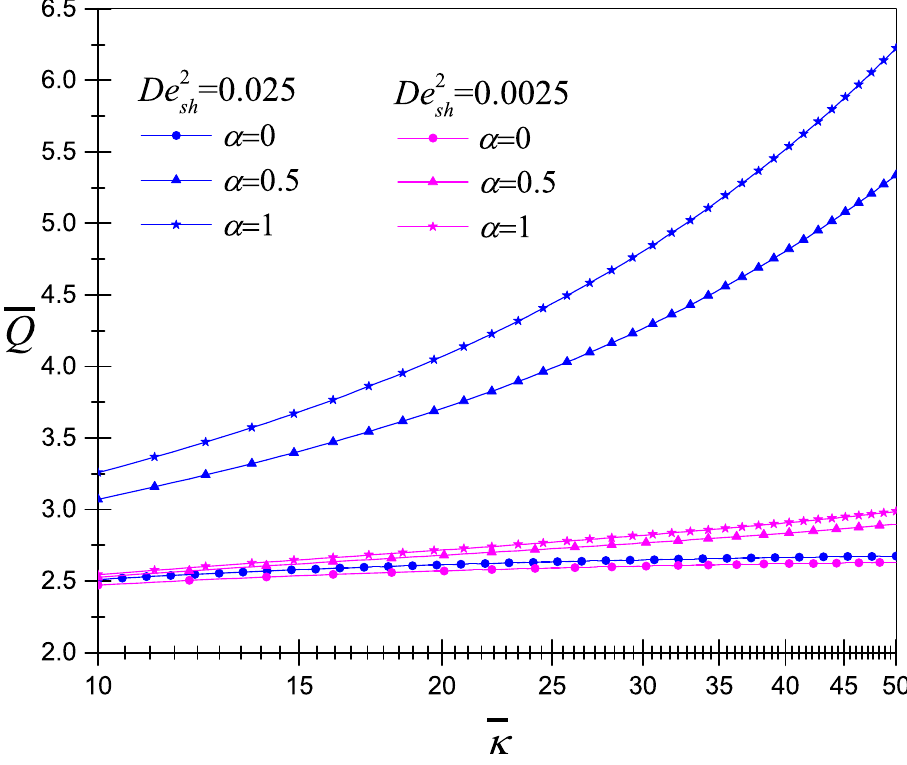
Figure 9. The volumetric flow rate as a function of the electrokinetic parameter for the codeformational ( α = 0 ) , mixture ( α = 0.5 ) and corotational ( α = 1 ) models, for De 2